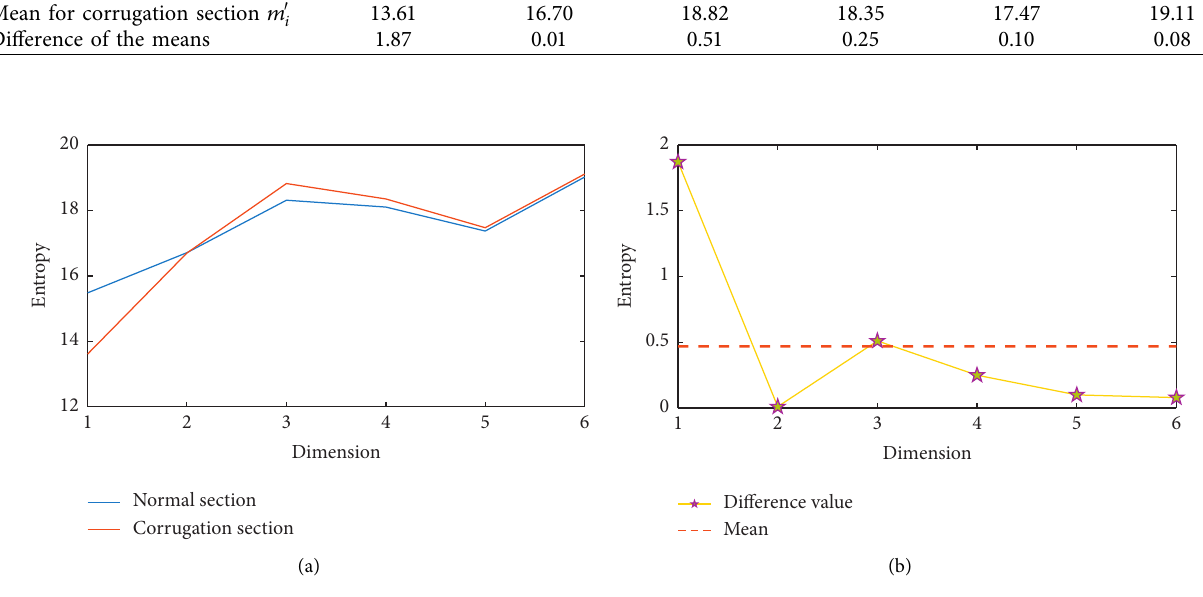
Figure 9: (a) The plot of the columnwise mean values of the entropy for each subsignal. (b) The difference of the means between the normal section and the corrugation section.